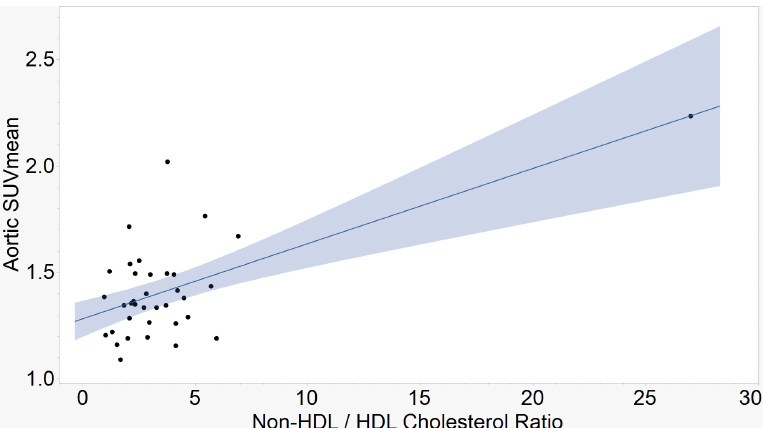
Figure 3. Aortic SUVmean vs. Atherogenic Coefficient (AC). The ratio between non-high density lipoprotein cholesterol and high-density lipoprotein cholesterol demonstrates a strong, positive correlation with mean tracer uptake in the aorta. (r = 0.63, p < 0.0001, n =